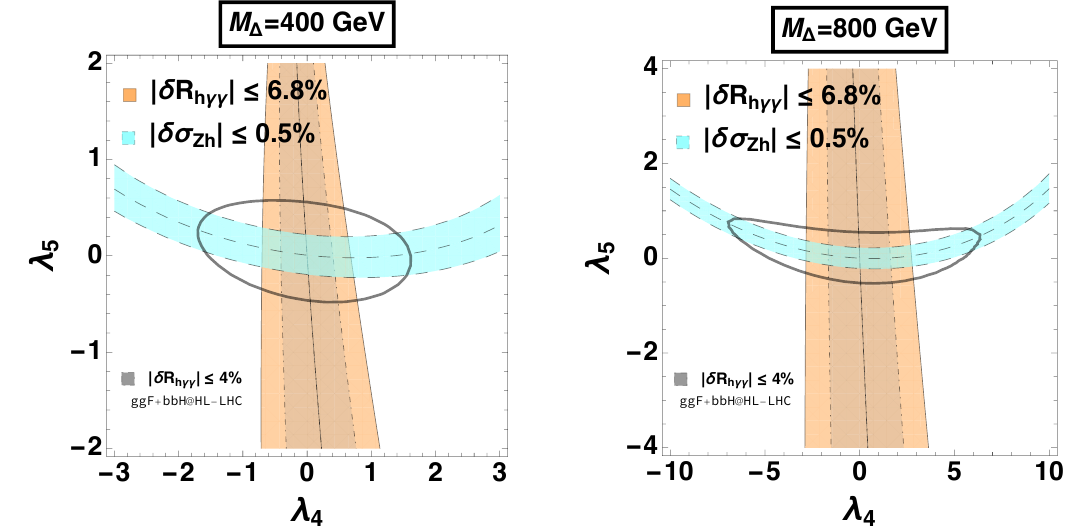
Figure 3. Contour comparison of | δσ Zh | ≤ 0 . 5% ( 1 σ cyan band with dashed central and outer lines) and | δR 6 . 8% ( 1 σ orange band with solid central and outer lines) in complex triplet model hγγ | ≤ with M = 400 GeV (left) and M = 800 GeV (right), respectively. The ellipse on each plot denotes ∆ ∆ the 95% confidence level for the parameter λ and λ with corresponding fixed M . In addition, 4 5 ∆ the contour of | δR 4% ( 1 σ grey band with dashdotted central and outer lines) corresponding hγγ | ≤ to the accuracry at the HL-LHC via gluon fusion plus b ¯ bH is added for the comparison, where one can see that with higher precision on h → γγ decay rate a better constraint on the parameter λ 4 can be